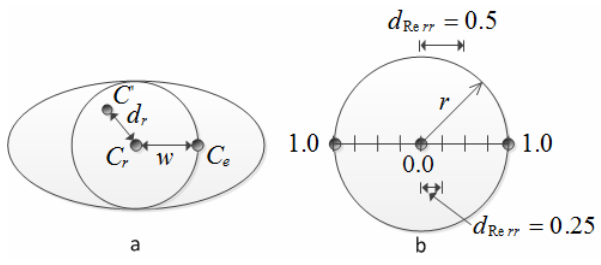
Figure 15: The model of one iris on the